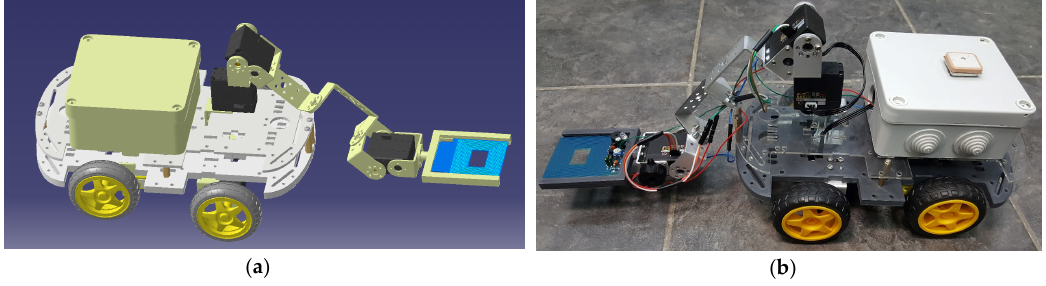
Figure 8. All-terrain intelligent robotic vehicle model for detection ready for testing and optimization: ( a ) virtual model; ( b ) laboratory prototype model for testing and development.